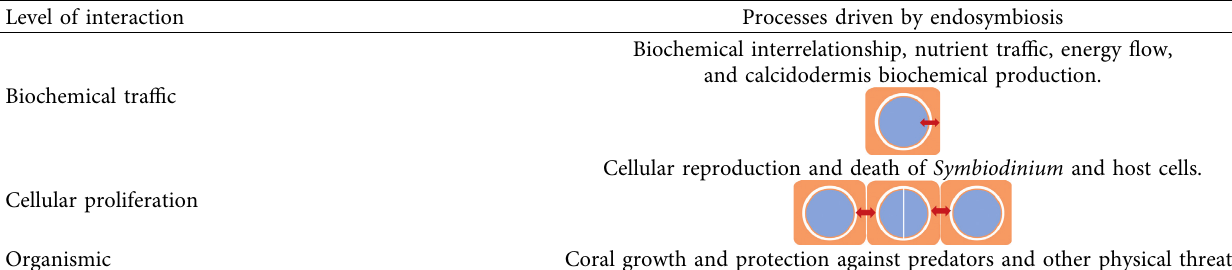
Table 2: Levels of interaction and processes that are enhanced by endosymbiosis at each